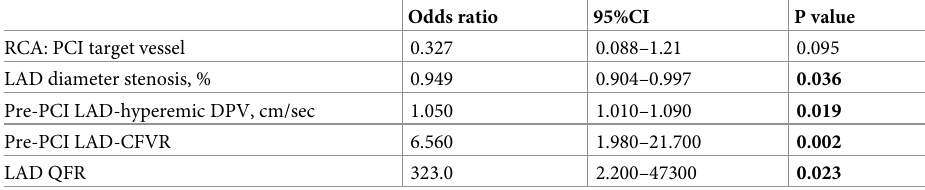
CI = confidence interval, RCA = Right coronary artery, PCI = percutaneous coronary intervention, LAD =